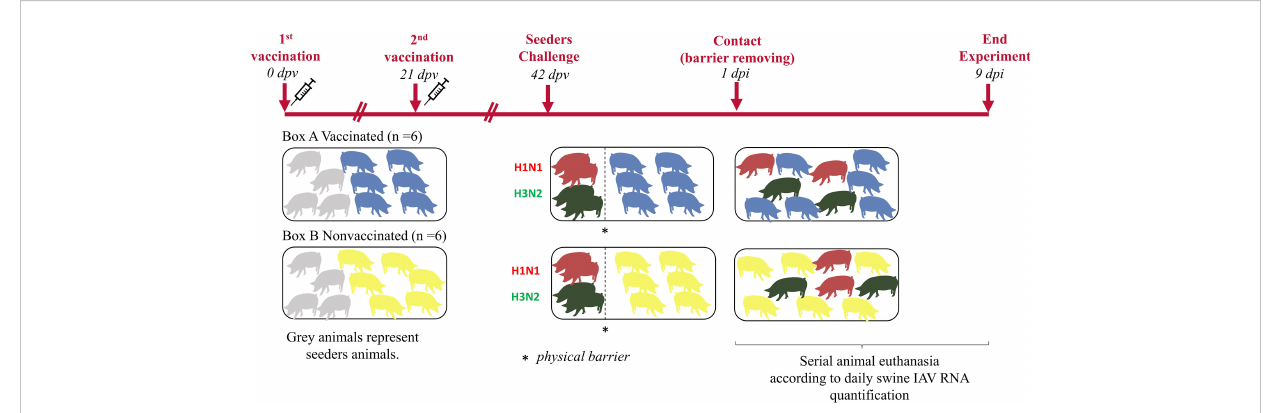
FIGURE 1 Experimental design and animal distribution. Vaccinated and nonvaccinated pigs are represented in blue and yellow fi gures, respectively. Seeders animals are represented in grey until the day of their challenge when pigs challenged with H1N1 are represented in red meanwhile those challenged with H3N2 are in